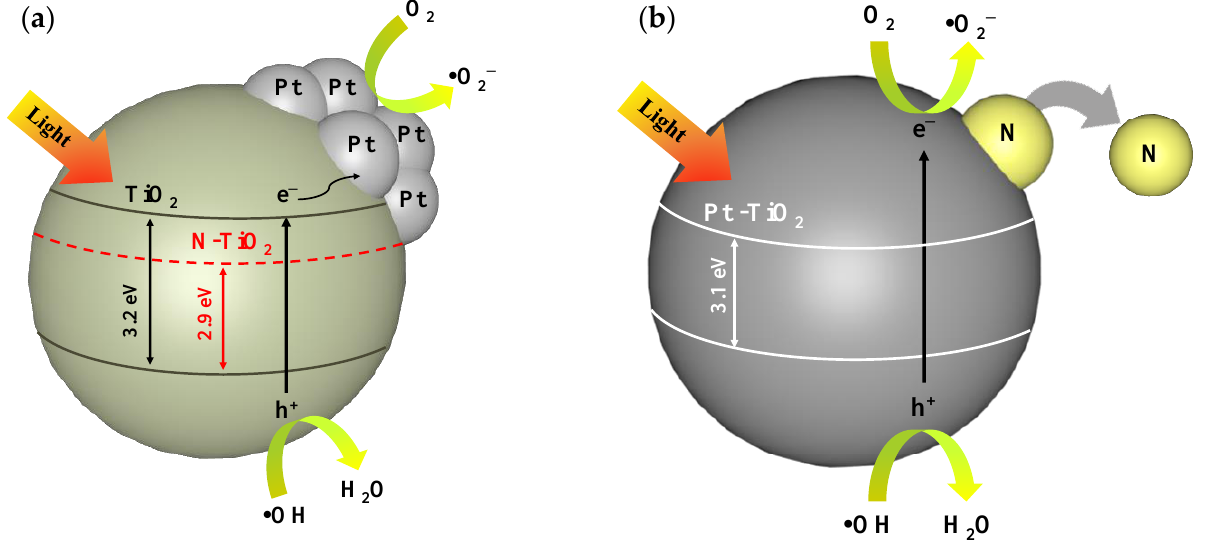
Figure 10. The mechanism reaction for ( a ) NP seq -TiO 2 photocatalyst and ( b ) PN rev -TiO 2 photocatalysts.